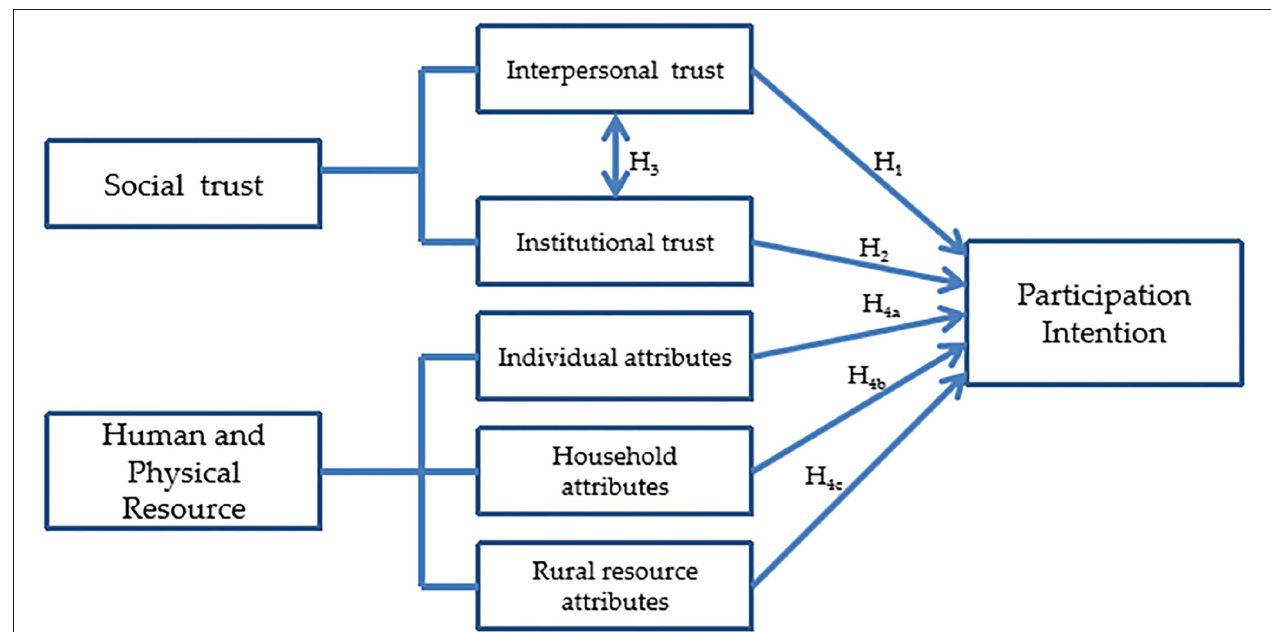
FIGURE 1 | Theoretical